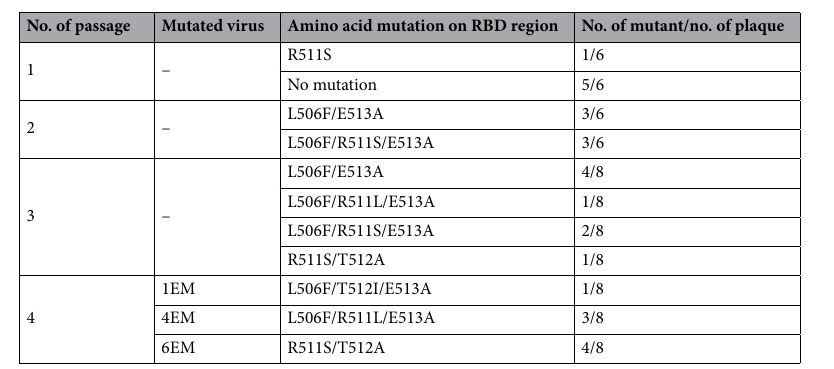
Table 2. Amino acid sequence of purified isolates during consensus passage in presence of nAb KNIH90-F1.